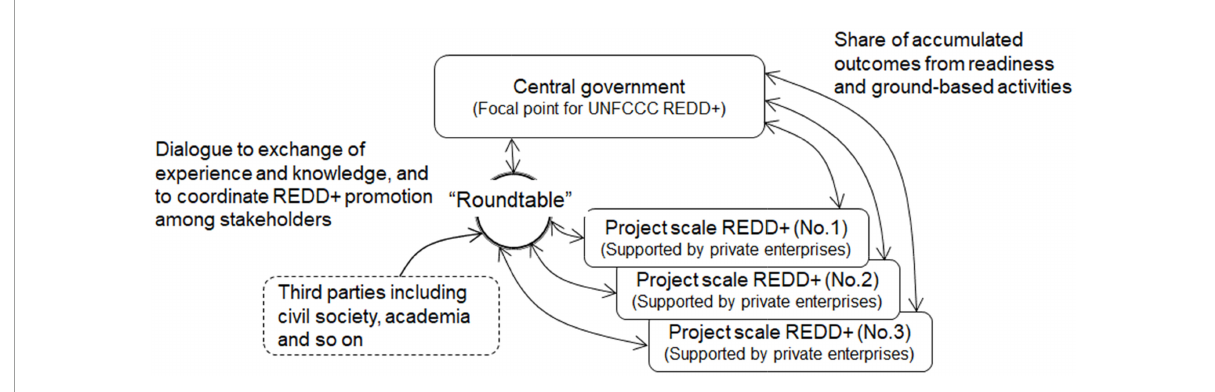
FIGURE2 Proposed future roundtable involving national-scale and project-scale reducing emissions from deforestation and forest degradation (REDD+) stakeholders.